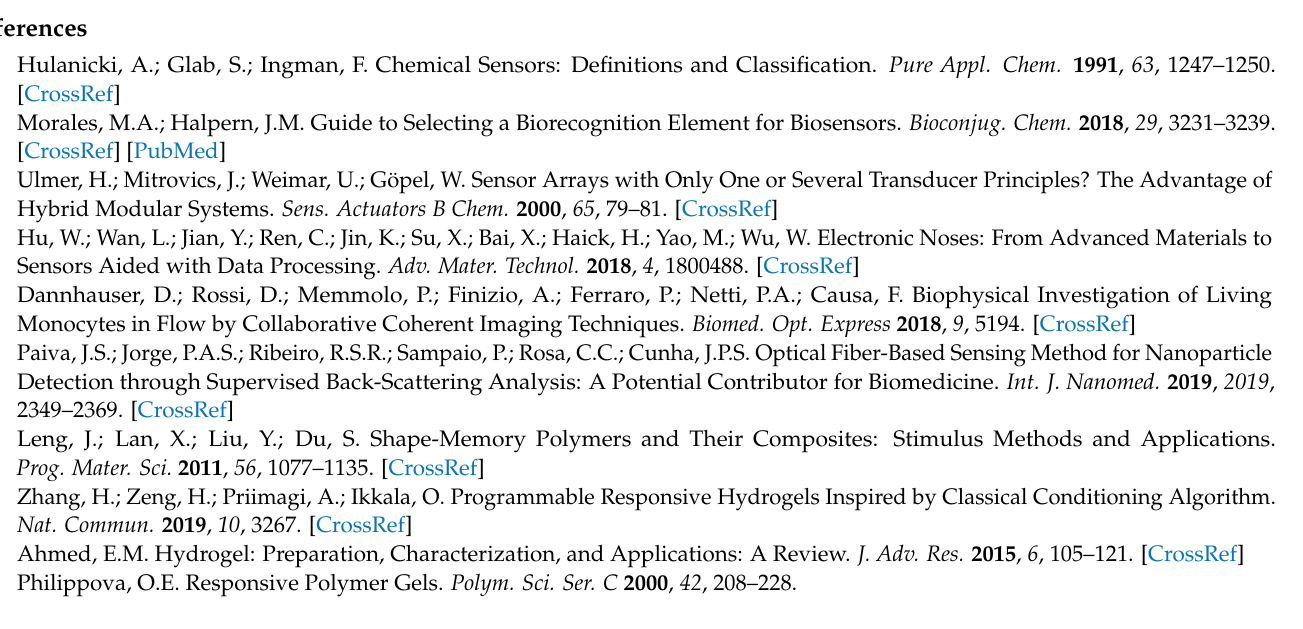
Figure S2: Zeta potential at pH 7.4 of the nanogels, Figure S3: Optical spectra of the surrounding media collected at different times, Figure S4: Image of the device. Table S1: Composition of the nanogels. Table S2: Zeta potential and Z-average of the